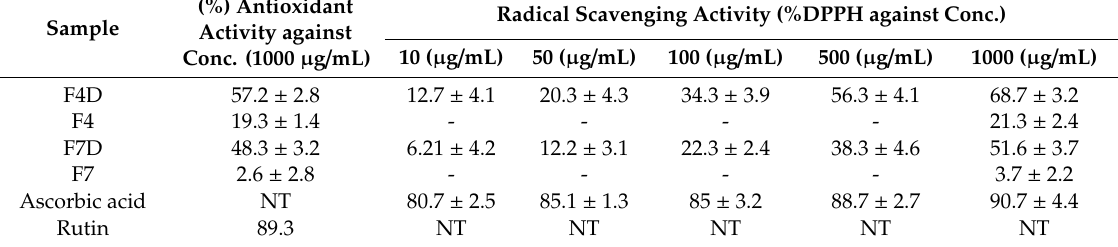
Table 4. 2,2-diphenyl-1-picrylhydrazyl (DPPH) scavenging and antioxidant activities of F4- (BSO/I988/KolliphorEL (35/15/50 % w/w )) and F7-(HCO-30), with and without CUR. F4 and F7 denote the blank formulations, and F4D and F7D the drug-loaded formulations, respectively.